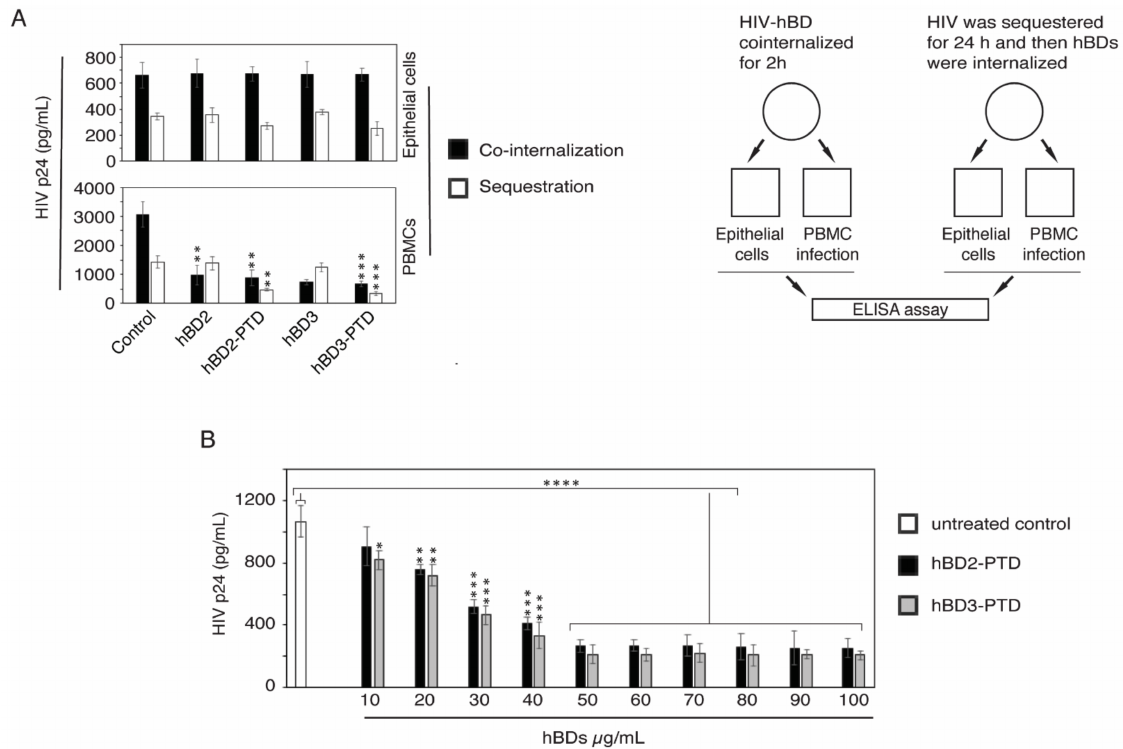
Figure 2. PTD does not change the anti-HIV function of hBD-2 and -3 proteins. ( A , left panel) hBD-2 and -3, with or without PTD signal (100 µ g/mL each), were added to the apical surface of polarized tonsil epithelial cells and incubated at 4 ◦ C for 30 min. Cells were washed, HIV-1 SF33 (20 ng/mL) was added to the apical surface, and cells were incubated at 37 ◦ C for hBD–HIV cointernalization. After 2 h, cells were homogenized and samples were divided into two groups. In parallel experiments, tonsil cells were exposed to HIV-1 SF33 (20 ng/mL) for viral sequestration; after 24 h, hBDs (100 µ g/mL) were added to the apical surface of the cells for 2 h. Cells were then homogenized and divided into two groups. One group of samples was examined by ELISA p24, which shows intracellular HIV-1. Another group of samples was used for infection of PBMC; after 5 days, PBMC were examined by ELISA p24, which shows the infectivity of intraepithelial virus. The design of these experiments is shown in the schematic diagram ( A , right panel). ( B ) Polarized tonsil epithelial cells were exposed to HIV-1 SF33 (20 ng/mL); after 48 h, cells were treated with various concentrations of hBD-2 PTD and hBD-3 PTD for 2 h. Cells were then homogenized, and PBMC were infected with intraepithelial virions. After 5 days, viral infection in PBMC was examined by ELISA p24. ( A , B ) Results are shown as mean ± SD ( n = 3) and were reproduced in two